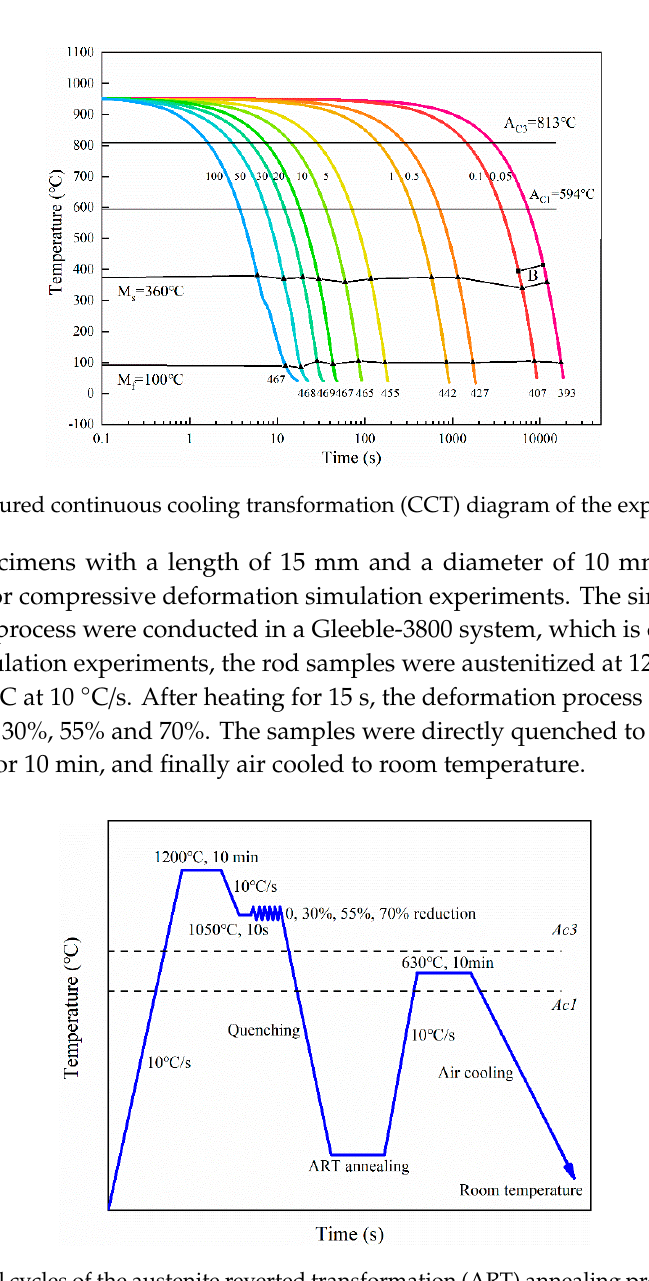
Figure 1. Measured continuous cooling transformation (CCT) diagram of the experimental steel.